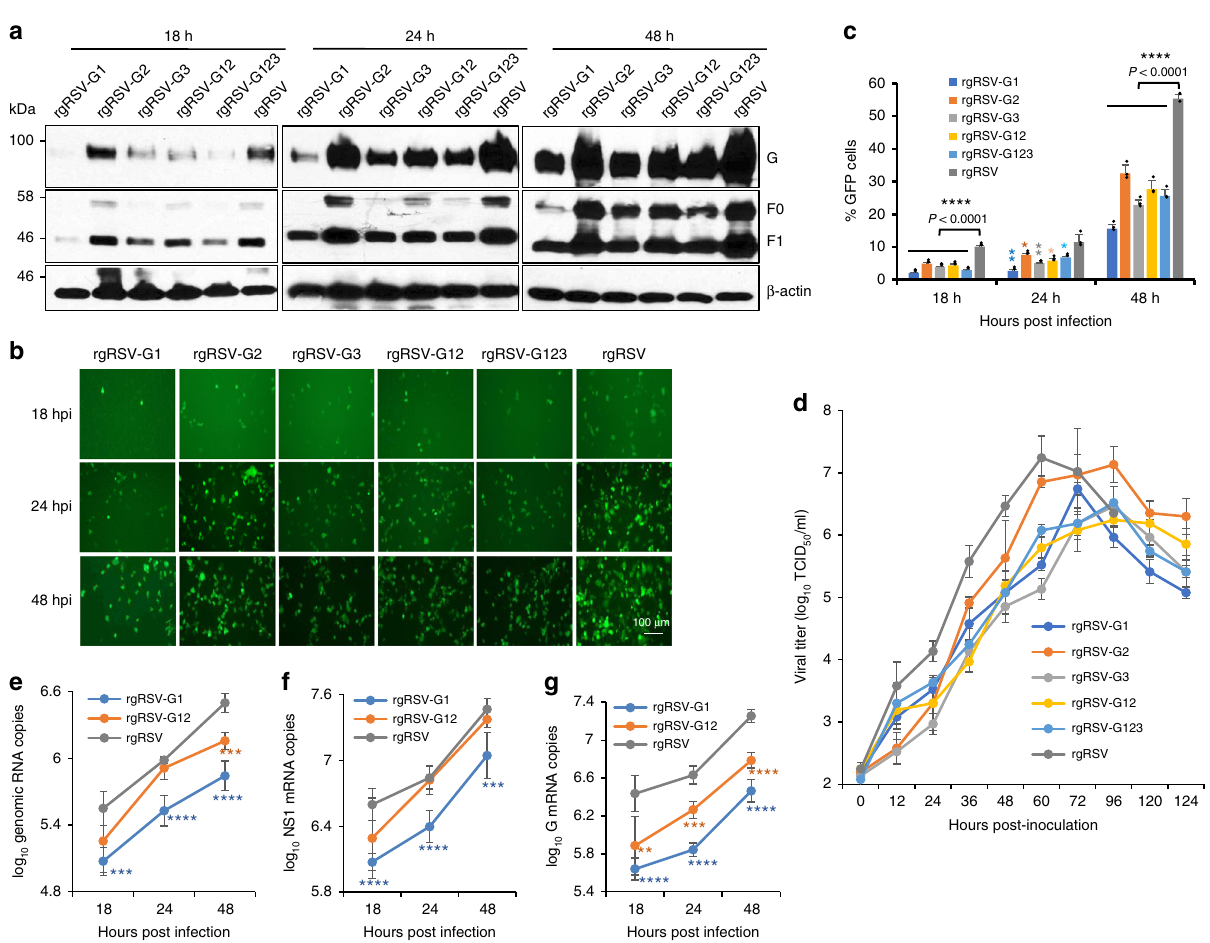
Fig. 7 m 6 A-abrogating RSV mutants have defects in replication in immortalized cells. a Immunoblot analysis of RSV proteins. Con fl uent A549 cells were infected with each rgRSV at an MOI of 0.1, cell lysates were harvested at 18, 24, and 48 h post-infection, and RSV proteins were detected by speci fi c antibodies against F and G protein. b GFP expression of m 6 A-de fi cient rgRSV mutants. Micrographs with ×10 magni fi cation (scale bar of 100 μ m) are shown. c Quanti fi cation of GFP-positive cells by fl ow cytometry. The P value (Student ’ s t -test) for rgRSV-G1, G2, G3, G12, and G123 at 18 h post-inoculation is **** P = 5.87 × 10 − 6 , **** P = 7.13 × 10 − 5 , **** P = 1.65 × 10 − 5 , **** P = 6.49 × 10 − 5 , and **** P = 6.98 × 10 − 6 , respectively; at 24 h post-inoculation is ** P = 0.00261, * P = 0.0418, ** P = 0.00766, * P = 0.0138, and * P = 0.0230 respectively; at 48 h post-inoculation is **** P = 3.55 × 10 − 6 , **** P = 1.82 × 10 − 4 , **** P = 9.83 × 10 – 6 , **** P = 7.78 × 10 − 5 , and **** P = 2.48 × 10 − 5 , respectively. d Single-step growth curve of m 6 A-de fi cient rgRSV mutants in A549 cells. Con fl uent A549 cells were infected with each rgRSV at an MOI of 1.0, supernatants were harvested, and viral titer was determined by TCID 50 assay. e RSV genomic RNA replication. At 18, 24, and 48 h post-infection, total RNA was puri fi ed from rgRSV-infected cells using TRizol, and genomic RNA was quanti fi ed by real-time RT-PCR using speci fi c primers annealing to the RSV leader sequence and GFP gene. The P value (Student ’ s t -test) for rgRSV-G1 at 18, 24, and 48 h is *** P = 0.000653, **** P = 8.66 × 10 − 5 , and **** P = 1.33 × 10 − 5 respectively. The P value for rgRSV-G12 at 48 h is *** P = 0.000141. f RSV NS1 mRNA transcription. Viral mRNA was separated from total RNA and quanti fi ed by real-time PCR using primers annealing to the NS1. The P value (Student ’ s t -test) for rgRSV-G1 at 18, 24, and 48 h is **** P = 1.80 × 10 − 5 , **** P = 1.11 × 10 − 4 , and *** P = 0.001, respectively. g RSV G mRNA transcription. The P value (Student ’ s t -test) for rgRSV-G1 at 18, 24, and 48 h is **** P = 7.13 × 10 − 5 , **** P = 5.10 × 10 − 6 , and **** P = 1.22 × 10 − 6 , respectively. The P value (Student ’ s t -test) for rgRSV-G12 at 18, 24, and 48 h is ** P = 0.00942, *** P = 0.000199, and **** P = 1.35 × 10 − 5 , respectively. Results are from three independent experiments. Flow cytometry data are expressed as mean ± standard deviation. RNA copy and viral titer are the geometric mean titer (GMT) of three independent experiments ± standard deviation. Western blots shown are the representatives of three independent experiments